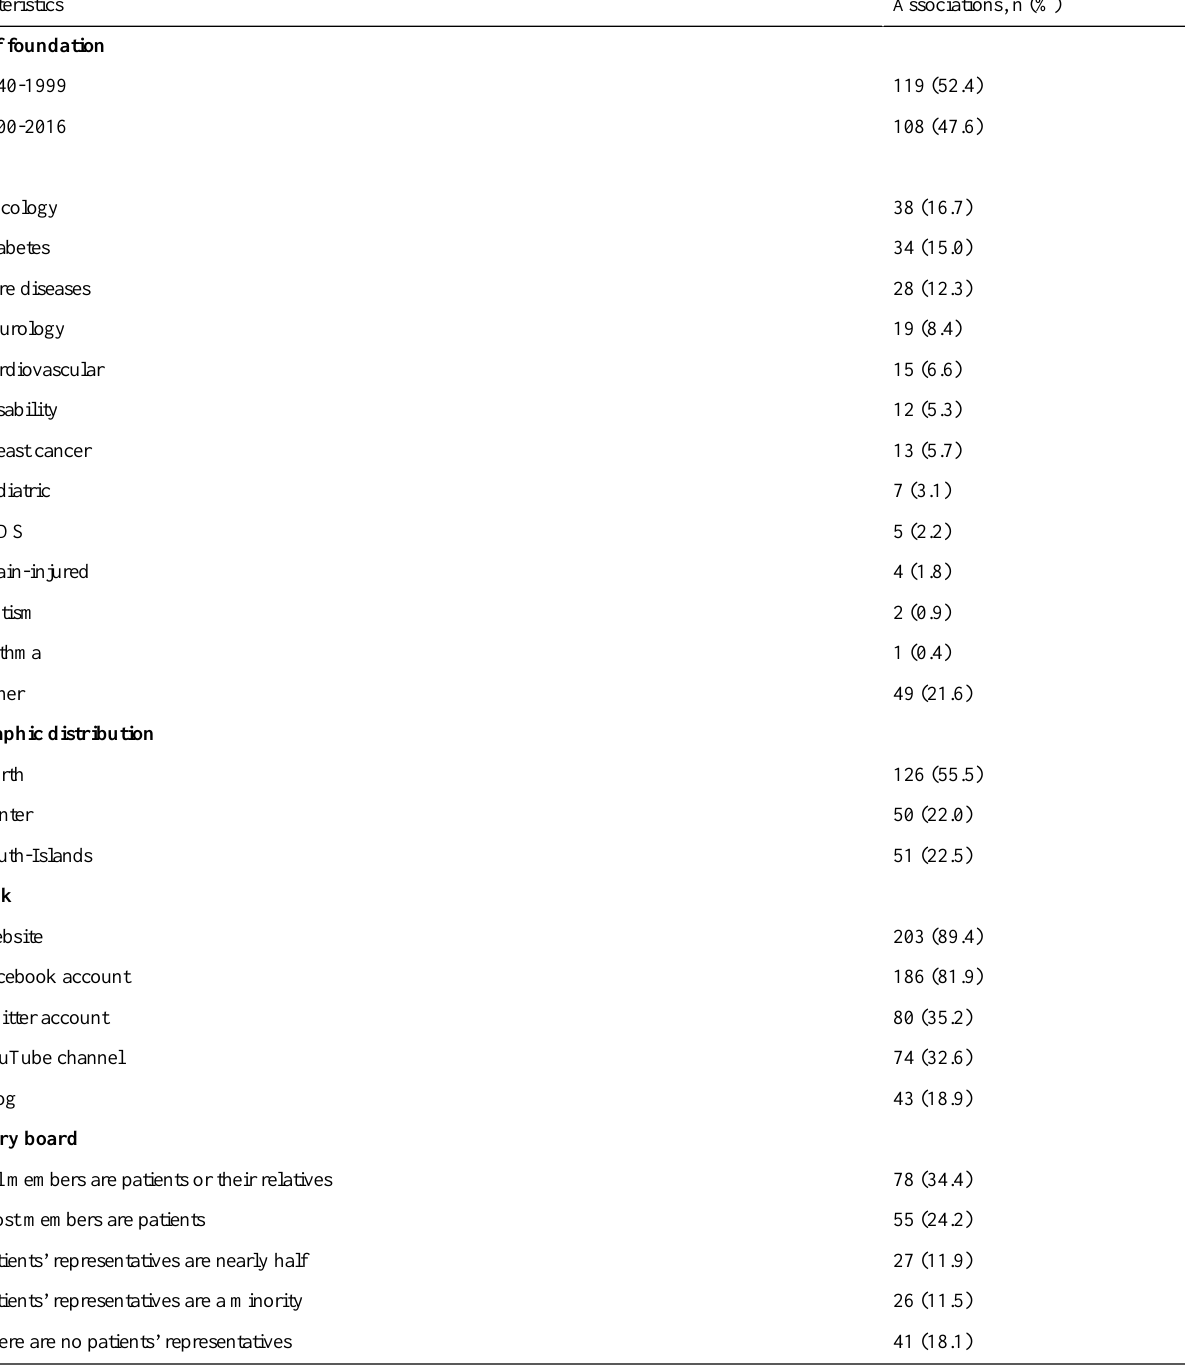
Table 1. Characteristics of patients’health care advocacy associations